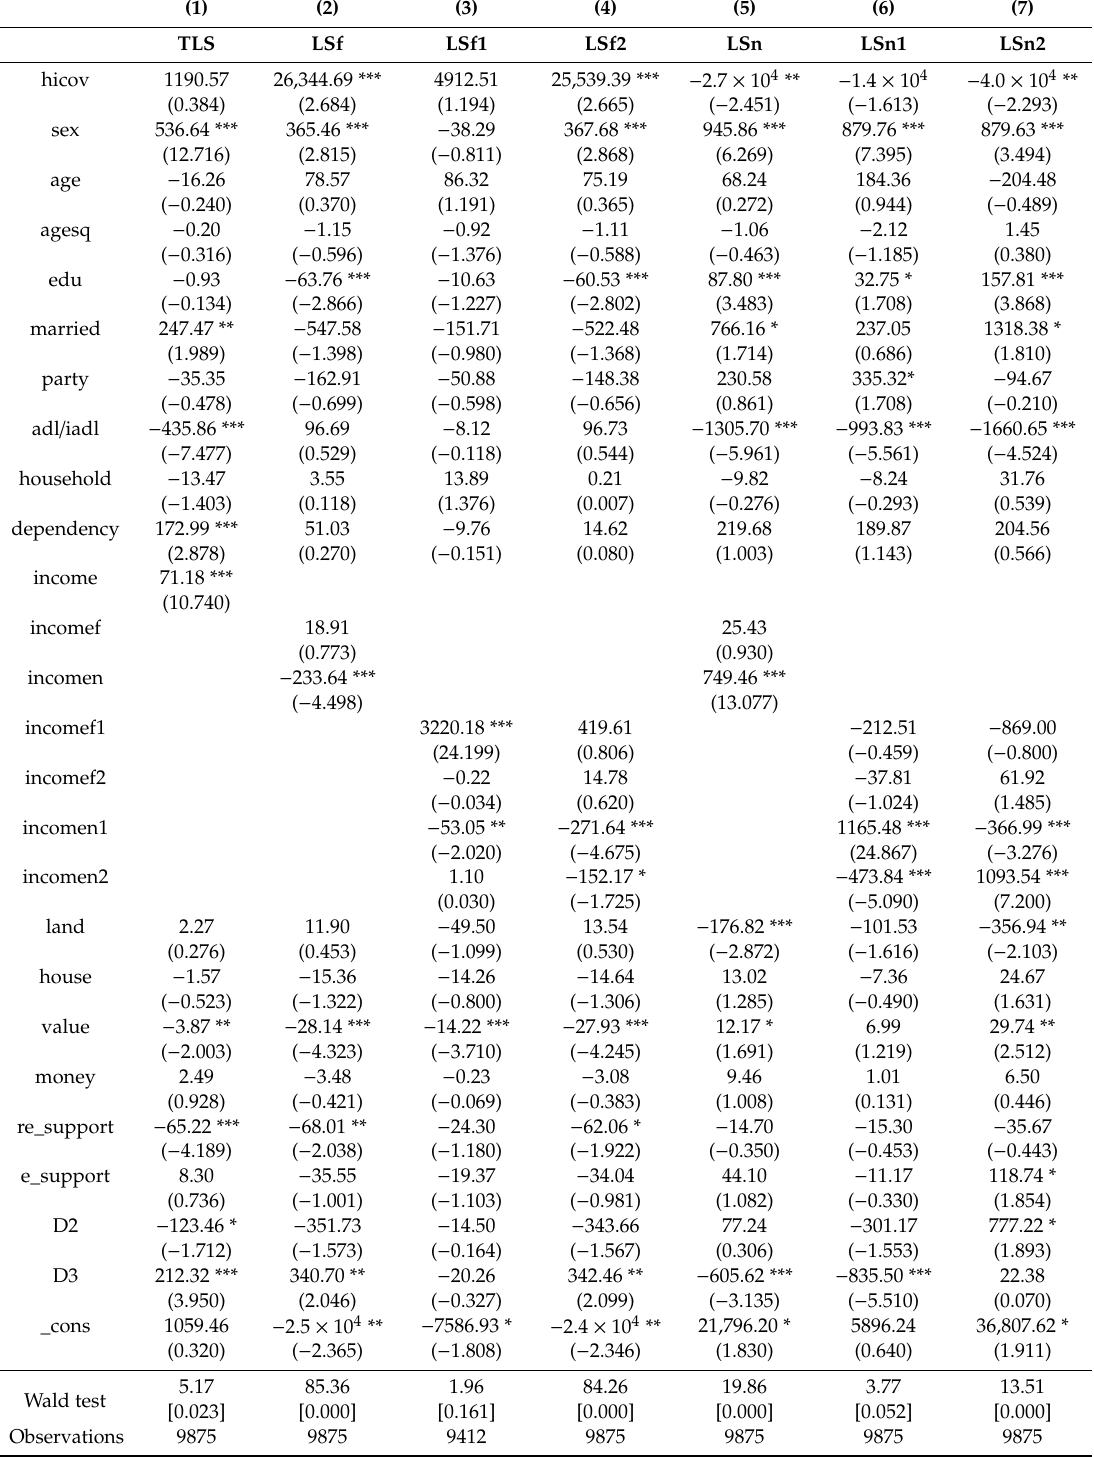
Table 12. Estimation of labor supply model of medical insurance